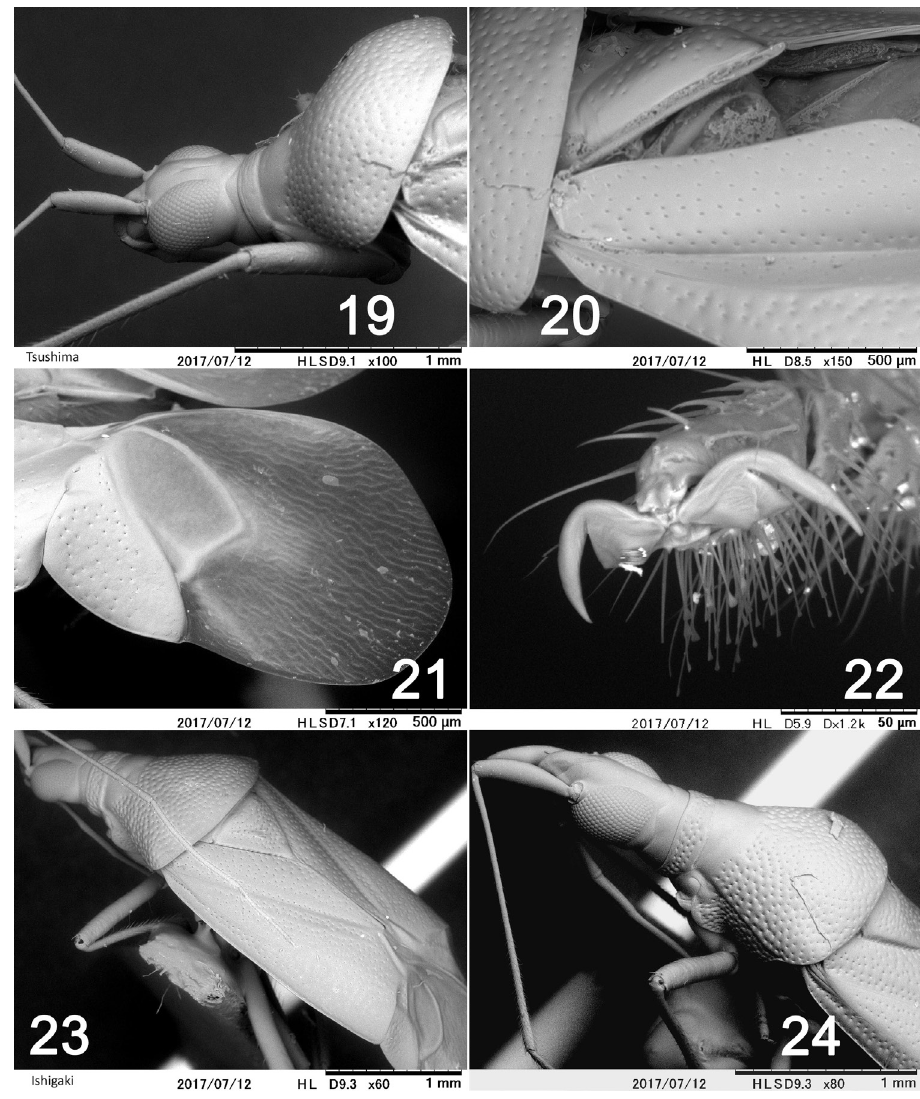
Figures 19–24. Scanning electron micrographs of Fingulus species. 19–22 F. henrytomi 23–24 F. takahashii 19, 24 head and pronotum 20, 23 hemelytra 21 membrane 22 tarsal claw.